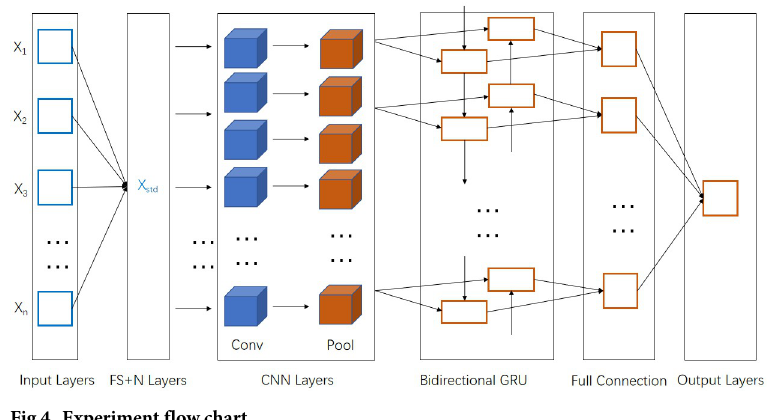
Fig 4. Experiment flow